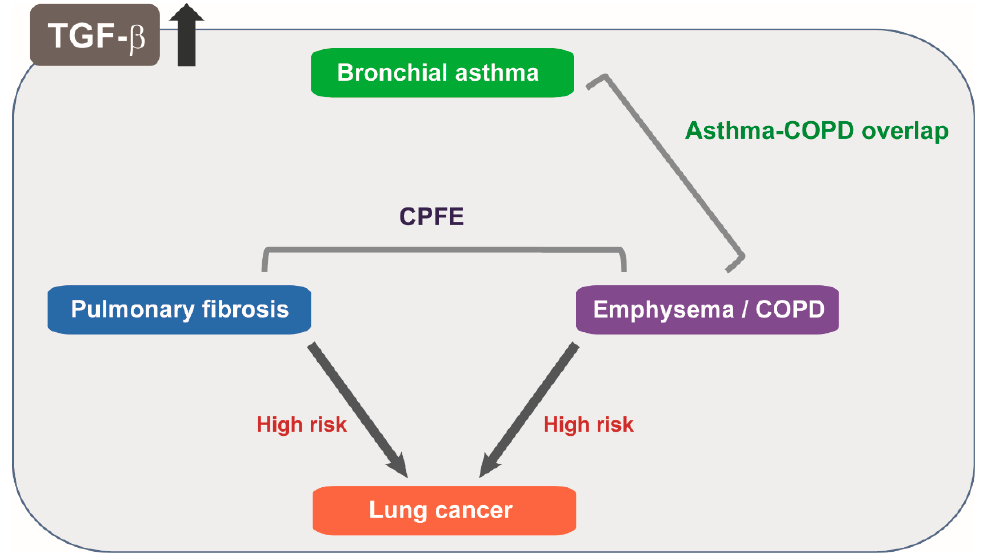
Figure 3. Upregulation of TGF- β ligands is observed in bronchial asthma, pulmonary fibrosis, emphysema, and lung cancer. Combined pulmonary fibrosis and emphysema (CPFE) and asthma-COPD overlap are increasingly recognized as distinct entities. Pulmonary fibrosis and emphysema are known as independent risk factors for lung cancer.